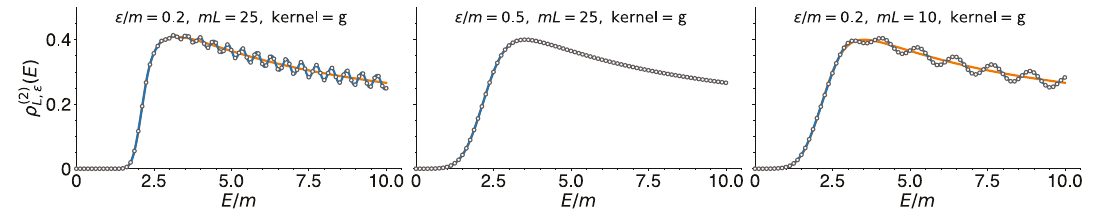
Figure 10 . Theoretically predicted two-particle spectral densities for three sets of (cid:15)/m and mL values (as indicated) with the Gaussian smearing kernel. Each panel includes the smeared infinite- volume results (orange), as well as the finite-volume smeared spectral density defined in eq. (C.8) (blue). The points arise from numerically evaluating the n = 1 term of eq. (C.26) and combining with ρ ∞ ,(cid:15) ( E ) .